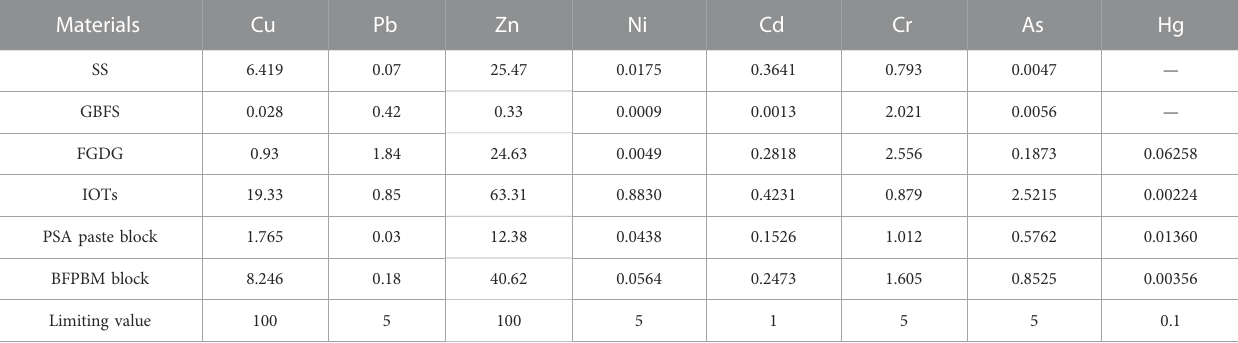
TABLE 3 The leaching concentrations of heavy metals from some raw materials, the PSA paste block and the BFPBM block after 28d curing age ( μ g/L).